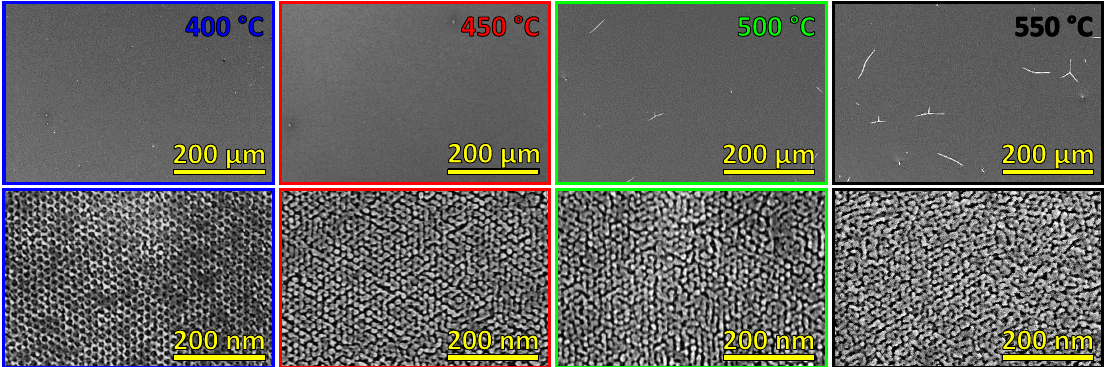
Figure 3. Influence of calcination temperature on mesofilm morphology as observed by top-view SEM. Higher calcination temperatures cause mesostructure deteriorations and the formation of cracks at T > 500 ◦